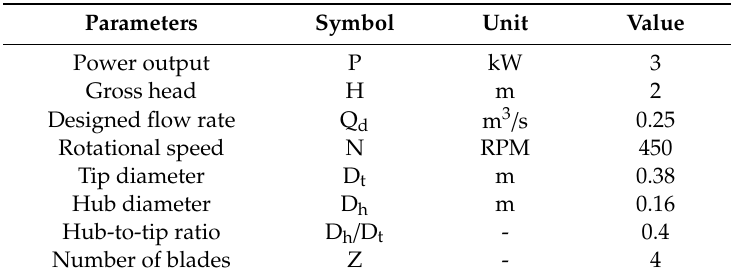
Figure 1. Runner blade. ( a ) Manufactured prototype; ( b ) 3D geometry of the turbine. Table 1. Turbine specifications.